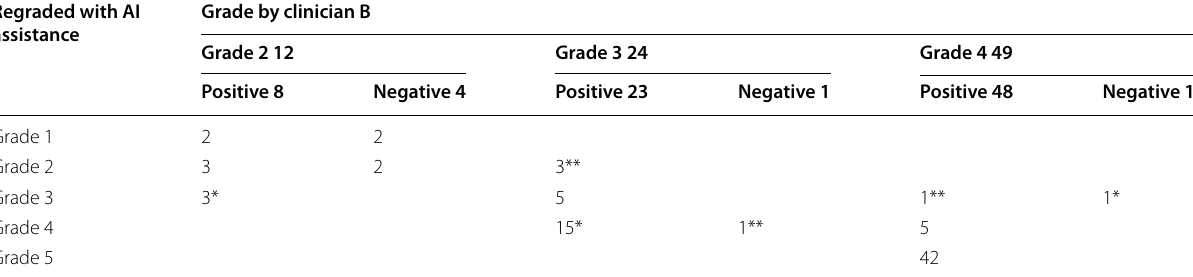
‘*’ denotes diagnoses corrected by the AI assistance including (1) false-positive and false-negative samples reconsidered as grade 3, and (2) samples of grade 3 reconsidered correctly as grade 2 or grade 4 ‘**’ denotes mistakenly reconsidered diagnoses including (1) true-positive and true-negative samples reconsidered as grade 3, and (2) grade 3 samples reconsidered mistakenly as grade 2 or grade 4